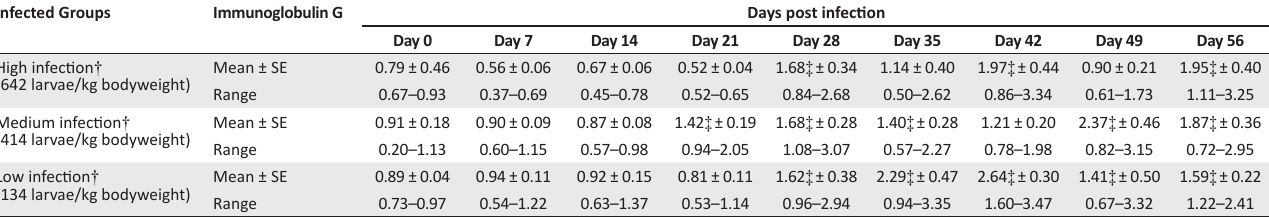
TABLE 7: Mean change* in anti-Trichinella IgG in sera of Nile crocodiles ( Crocodylus niloticus ) experimentally infected with Trichinella zimbabwensis. Infected